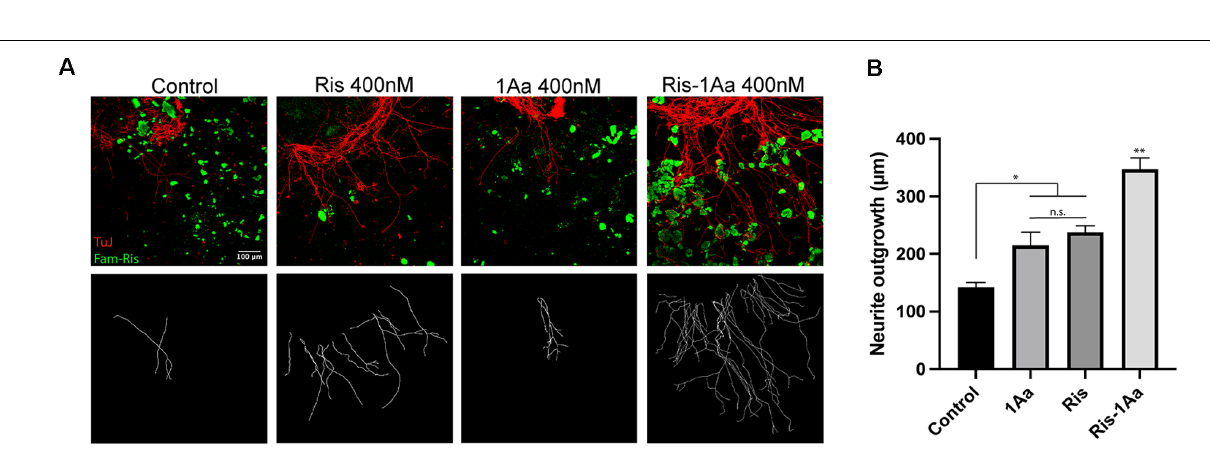
FIGURE 5 | Ris-1Aa retains neurotrophic activity following binding to the bone matrix in vitro . (A) SGN neurite outgrowth after preincubation of drugs with hydroxyapatite nanoparticles (HA). Neurites were stained with neuronal marker TuJ (red), HA was visualized with Fam-Ris (green), and nuclei were labeled with DAPI (blue). Scale bar represents 100 µ m. Images are representative of four independent experiments. (B) Quantification of neurite outgrowth compared to DMSO control (* represents p ≤ 0.05, ** represents p ≤ 0.01; n.s., not